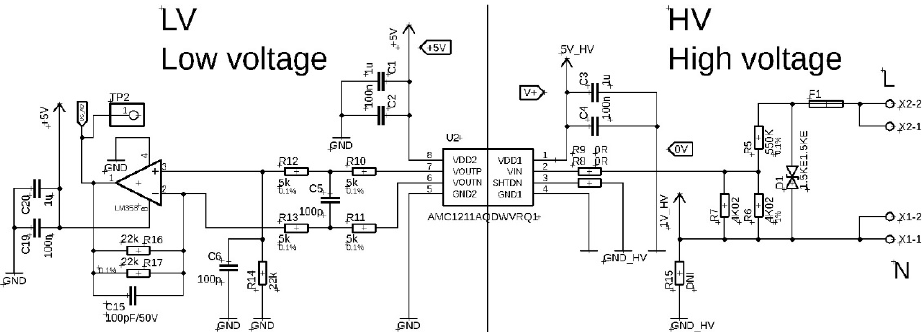
Figure 7. The circuit diagram of the fixture with the resistive divider and the AMC1211 integrated circuit.